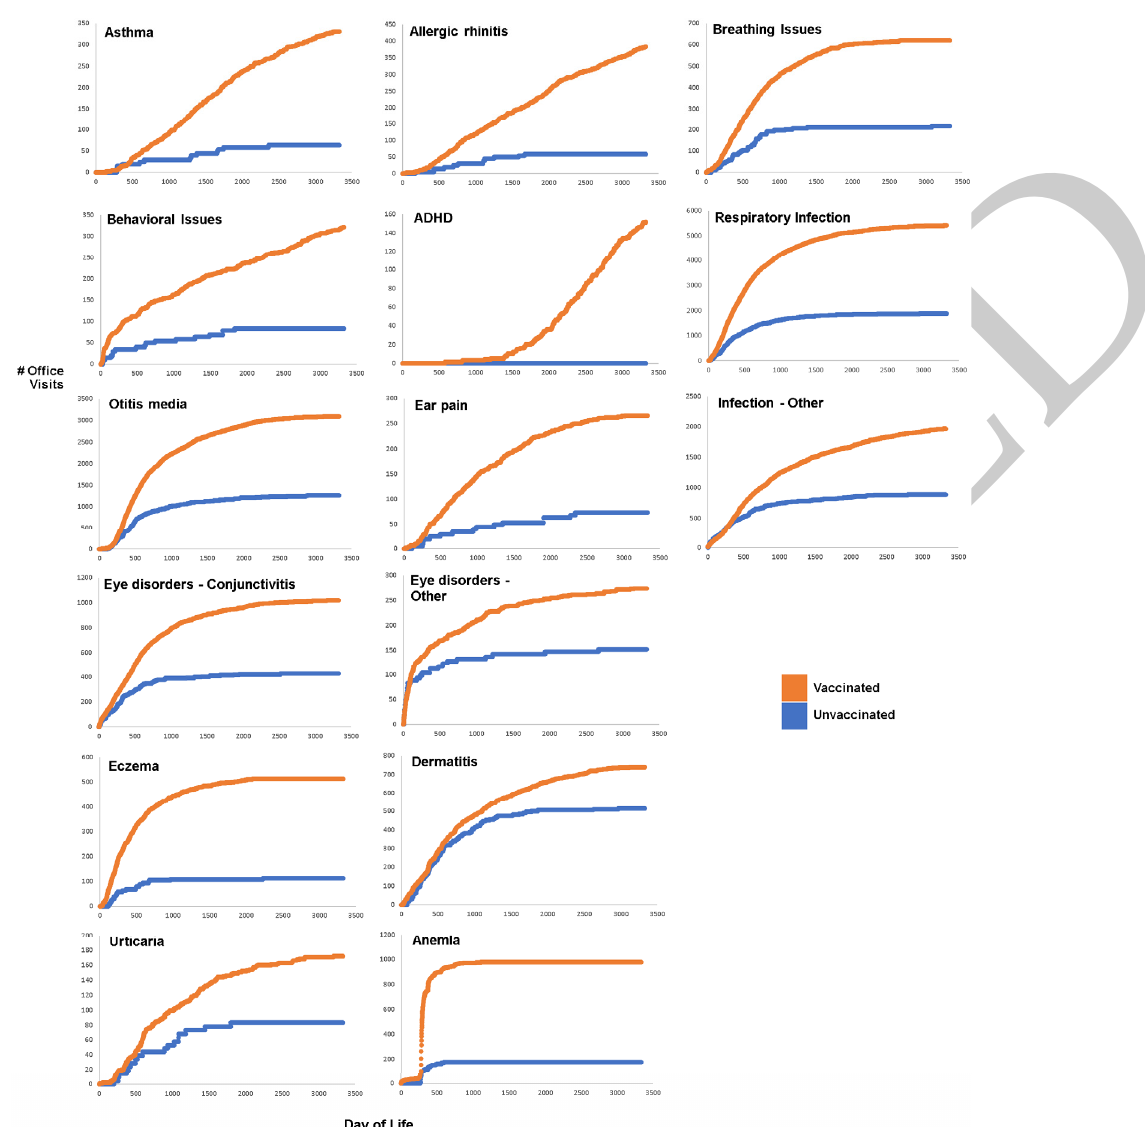
Figure 5. Analysis 5. Cumulative o ffi ce visits in the vaccinated (orange) vs. unvaccinated (blue) patients born into the practice: the clarity of the age-specific di ff erences in the health fates of individuals who are vaccinated (2763) compared to the 561 unvaccinated in patients born into the practice over ten years is most strikingly clear in this comparison of the cumulative numbers of diagnoses in the two patient groups. The number of o ffi ce visits for the unvaccinated is adjusted by a sample size multiplier factor (4.9) to the expected value as if the number of unvaccinated in the study was the same as the number of